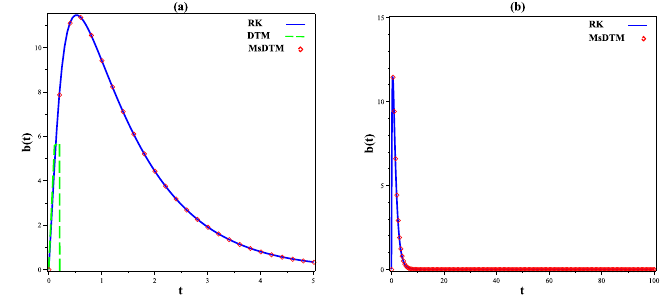
Figure 10: The density of the humans infected with avian influenza with r 0 = 0.9 and R 0 ≈ 7.1 .